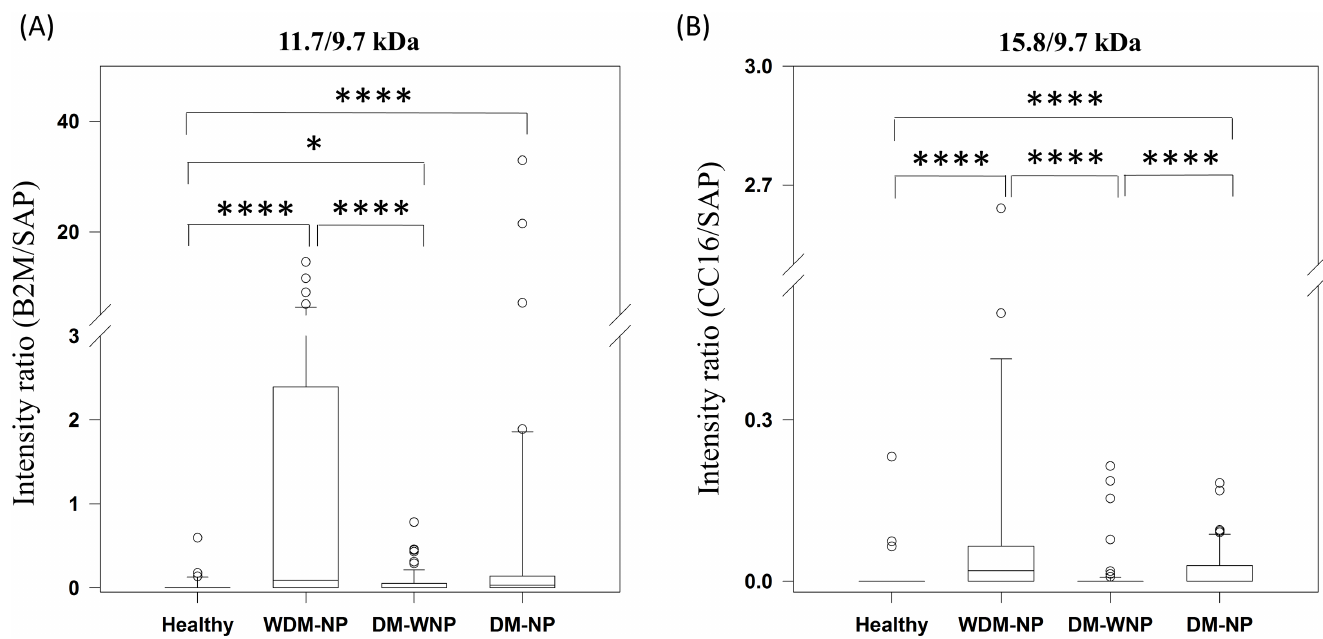
Fig 4. Excretion of (A) 11.7 kDa and (B) 15.8 kDa proteins in urine samples from 39 healthy, 44 WDM-NP, 85 DM-WNP, and 51 DM-NP subjects. The relative intensities are represented as box plots, expressed as the medium with quartile values (25%, 75%). Error bars indicate the minimum and maximum values. (cid:3) p < 0.05, (cid:3)(cid:3)(cid:3) p (cid:20) 0.001.